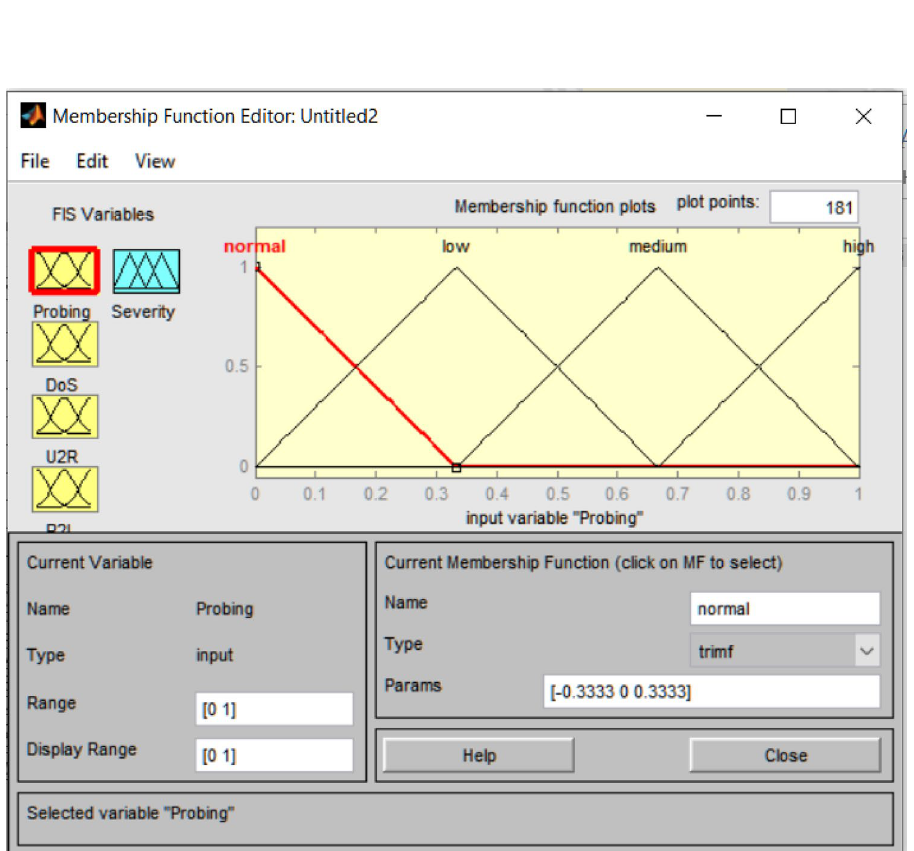
Fig. 7 Membership function editor for each of the fuzzy